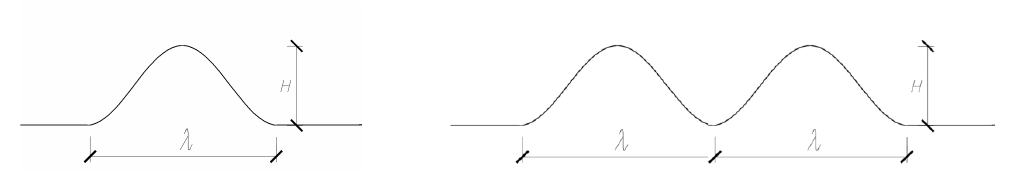
Figure 7. Single and multiple bumps characterized by cosine